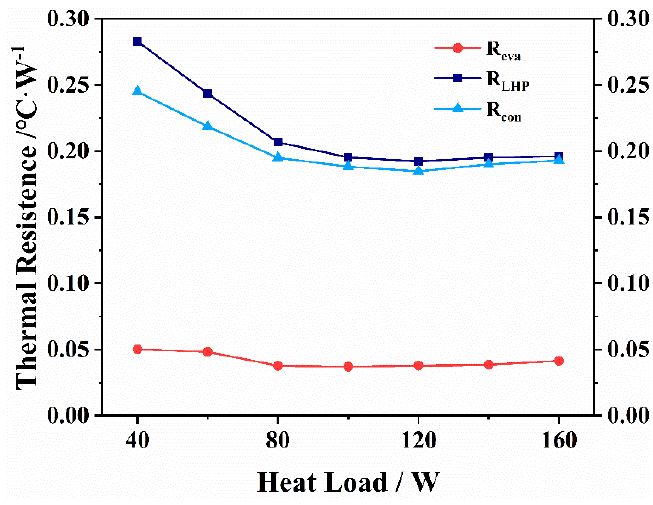
Figure 16. Thermal resistance at different heat loads of NO.5 position.